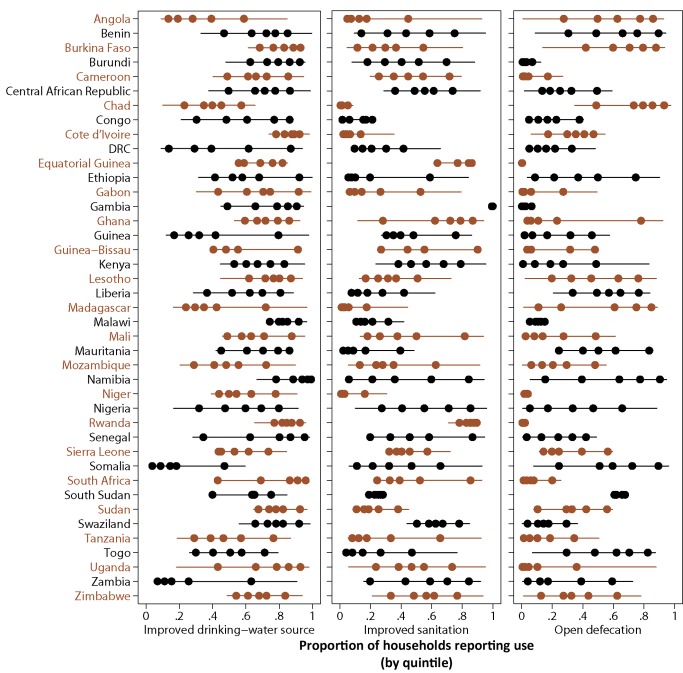
Distribution of modelled WSS coverage across administrative areas by country.Second administrative areas were stratified into quintiles based on coverage of each indicator. Dots show median proportion of households with access for each quintile; lines show the full range in coverage.